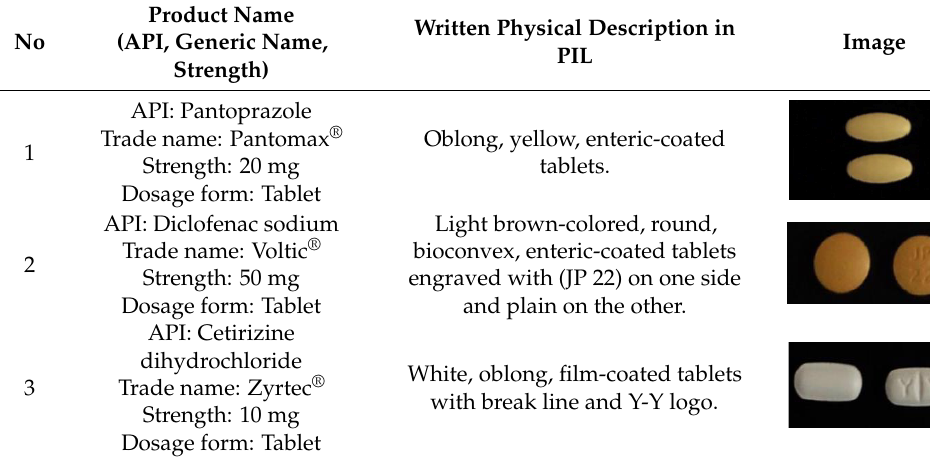
Table 3. Characteristics of pharmaceutical products with good written physical descriptions and matching.